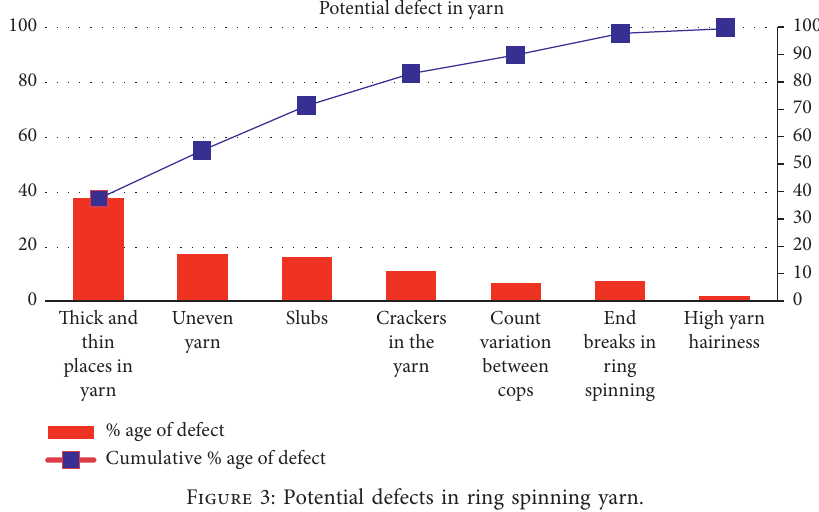
Figure 3: Potential defects in ring spinning yarn.